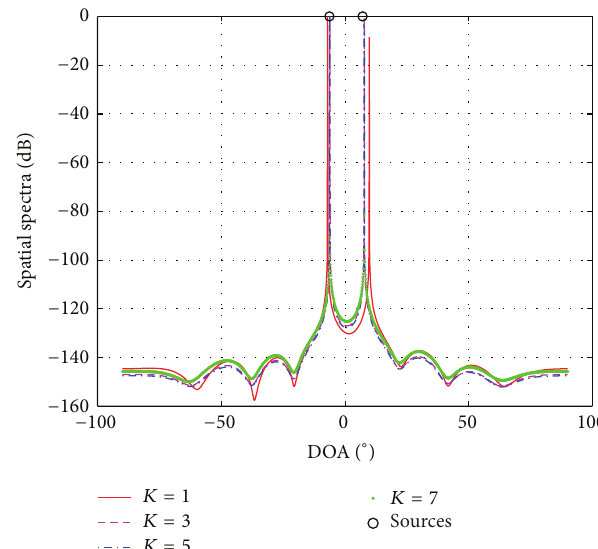
Figure3:SpatialspectraofsSSR-SSinrealdatatestsfortheassumed number of the sources 𝐾 = 1, 3, 5,7 , while the correct number of the sources is 𝐾 = 2 .